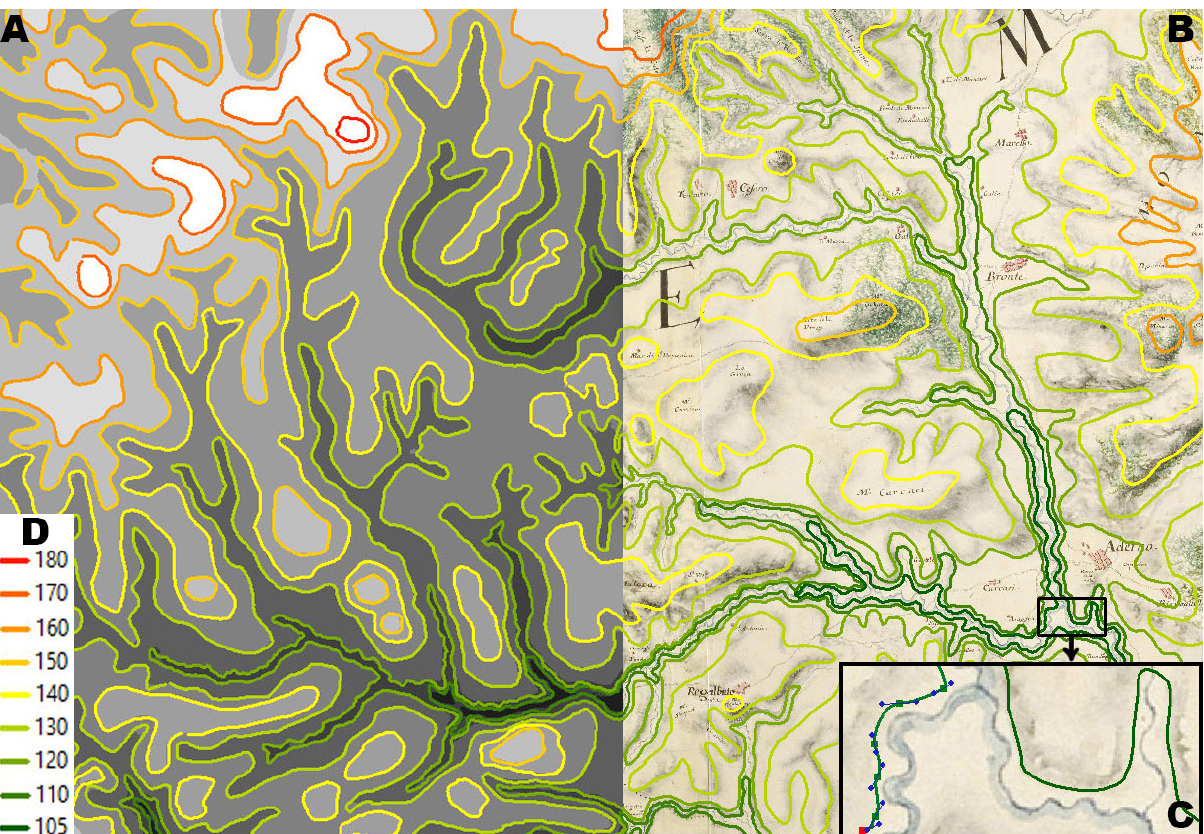
Figure 4. Vectorization of contour lines on the map of Sicily: ( A ): isochromatic map after vectorization; ( B ): contour lines on the layer with raster image; ( C ): manual way of drawing contour lines via Bézier curves; ( D ): nine contour lines with contrasting color.